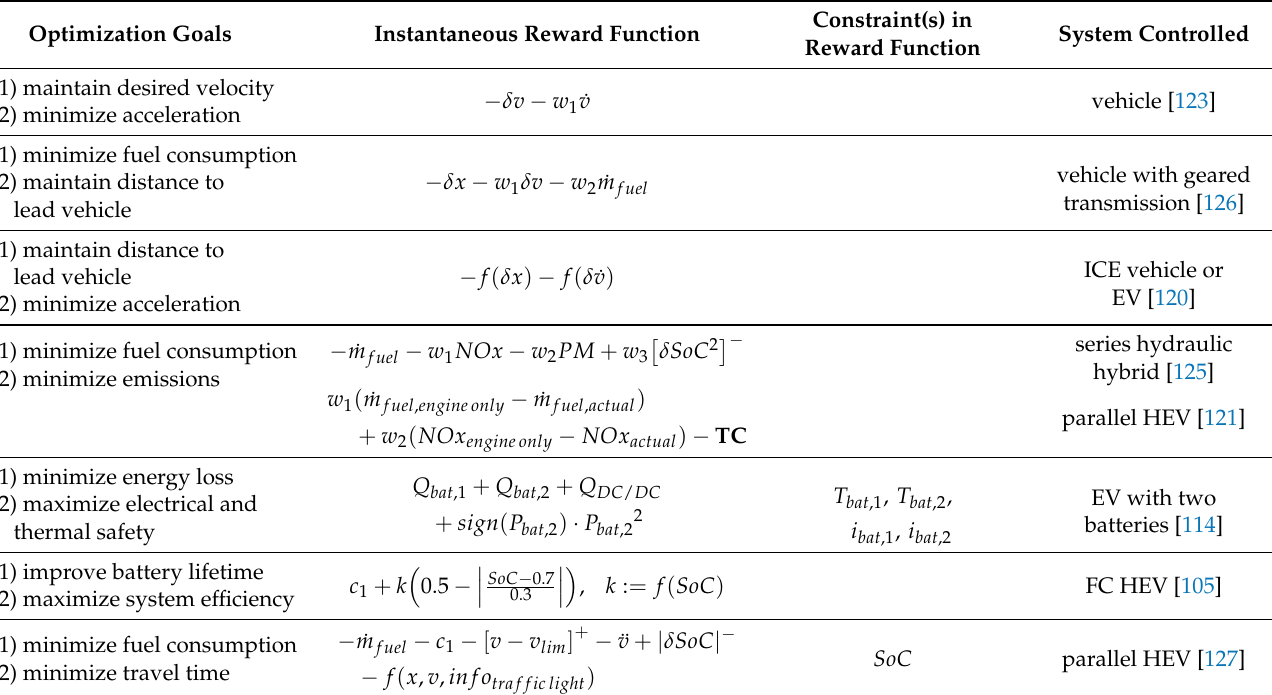
Table 5. Reward functions used in multi-objective RL-based powertrain control